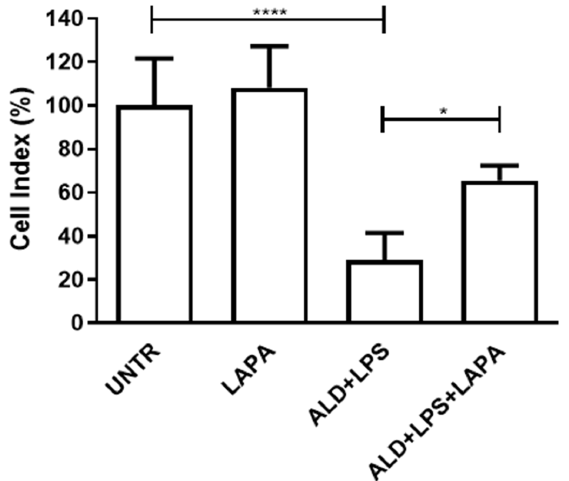
Figure 3. XCELLigence analysis of RAW 264.7 cell viability after treatment with ALD (50 μ M), LPS (10 μ g/mL) and 10 μ M Lapaquistat (LAPA). Results are indicated as mean ± standard deviation of 3 independent replicates, analyzed with ANOVA and corrected with Bonferroni post-test (* p < 0.05, **** p < 0.0001). UNTR: untreated.